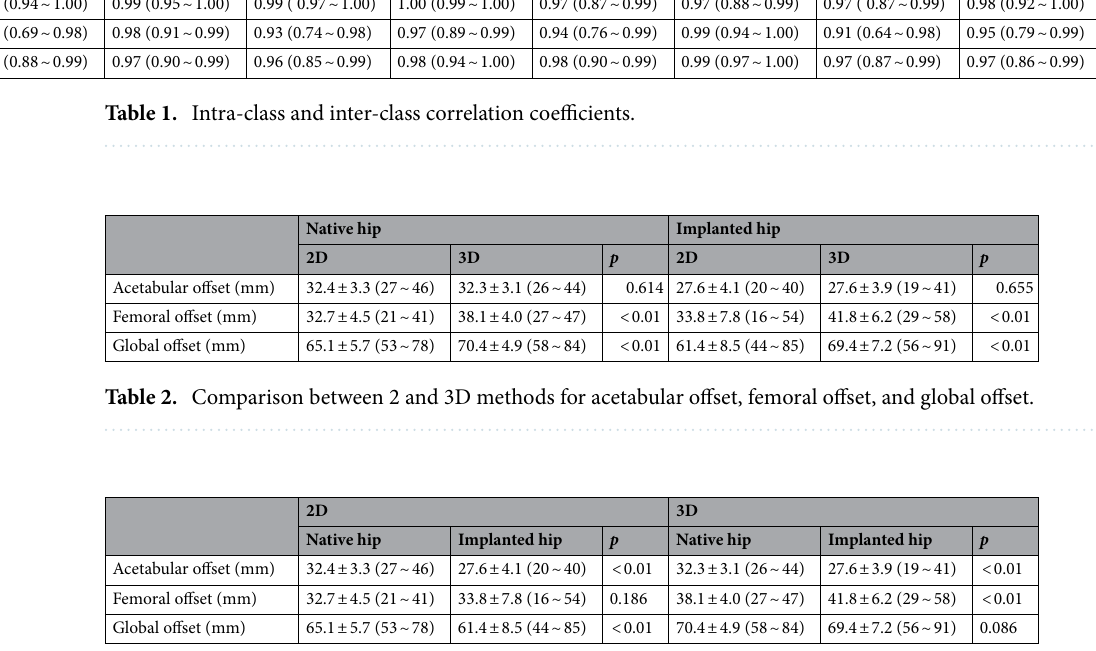
Table 1 lists the intra-class and inter-class correlation coefficients in native and implanted hips. There was almost perfect correlation for all measurements. In native hips, mean acetabular, femoral, and global offset values by the 2D method were 32.4 ± 3.3, 32.7 ± 4.5, and 65.1 ± 5.7 mm, respectively, and by the 3D method were 32.3 ± 3.1, 38.1 ± 4.0, and 70.4 ± 4.9 mm, respectively. In implanted hips, mean acetabular, femoral, and global offset values by the 2D method were 27.6 ± 4.1, 33.8 ± 7.8, and 61.4 ± 8.5 mm, respectively; and by the 3D method were 27.6 ± 3.9, 41.8 ± 6.2, and 69.4 ± 7.2 mm, respectively. Statistical analysis revealed no significant difference between the 2D and 3D methods for acetabu- lar offset in either native or implanted hips. However, a significant difference was found for femoral and global offset between the 2D and 3D methods for both native and implanted hips (Table 2). With both the 2D and 3D methods, acetabular offset in implanted hips was significantly smaller than that in native hips. There was no significant difference in femoral offset between native and implanted hips by the 2D method; however, there was significant difference in femoral offset between native and implanted hips by the 3D method. Regarding global offset, no significant difference was observed between native and implanted hips by the 3D method, and global offset was significantly smaller in implanted hips than in native hips by the 2D method (Table 3). Figure 4 shows a histogram of offset error between the 2D and 3D methods. For acetabular offset, values in all patients were within 6 mm for both native and implanted hips. However, there was considerable variation in femoral and global offset values with errors of up to 24 mm. For error of global offset between native and implanted hips by the 2D method, agreement within ± 3 mm was confirmed in 26/89 THAs (29.2%), and agree- ment within ± 5 mm was confirmed in 41/89 THAs (46.1%). In contrast, for error of global offset between native and implanted hips by the 3D method, agreement within ± 3 mm was confirmed in 51/89 THAs (57.3%), and agreement within ± 5 mm was confirmed in 73/89 THAs (82.0%) (Fig. 5).